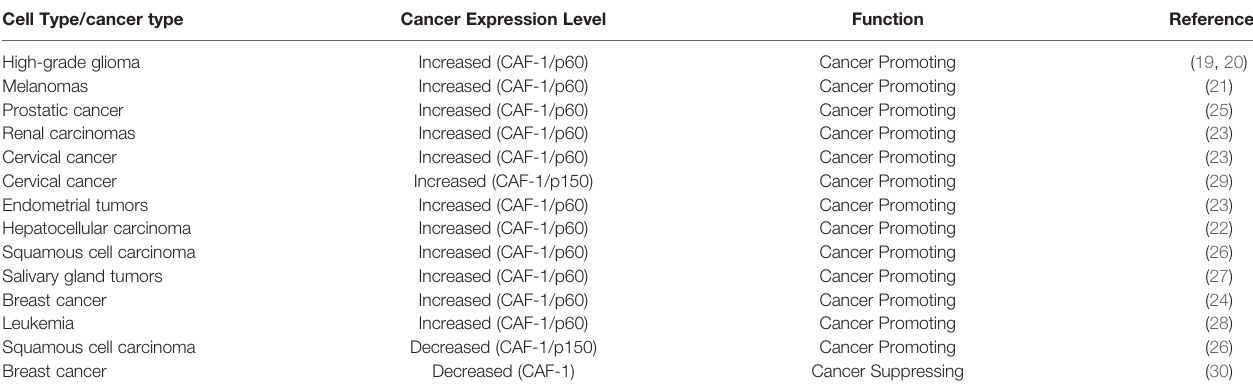
TABLE 1 | Expression of CAF-1 in tumor.